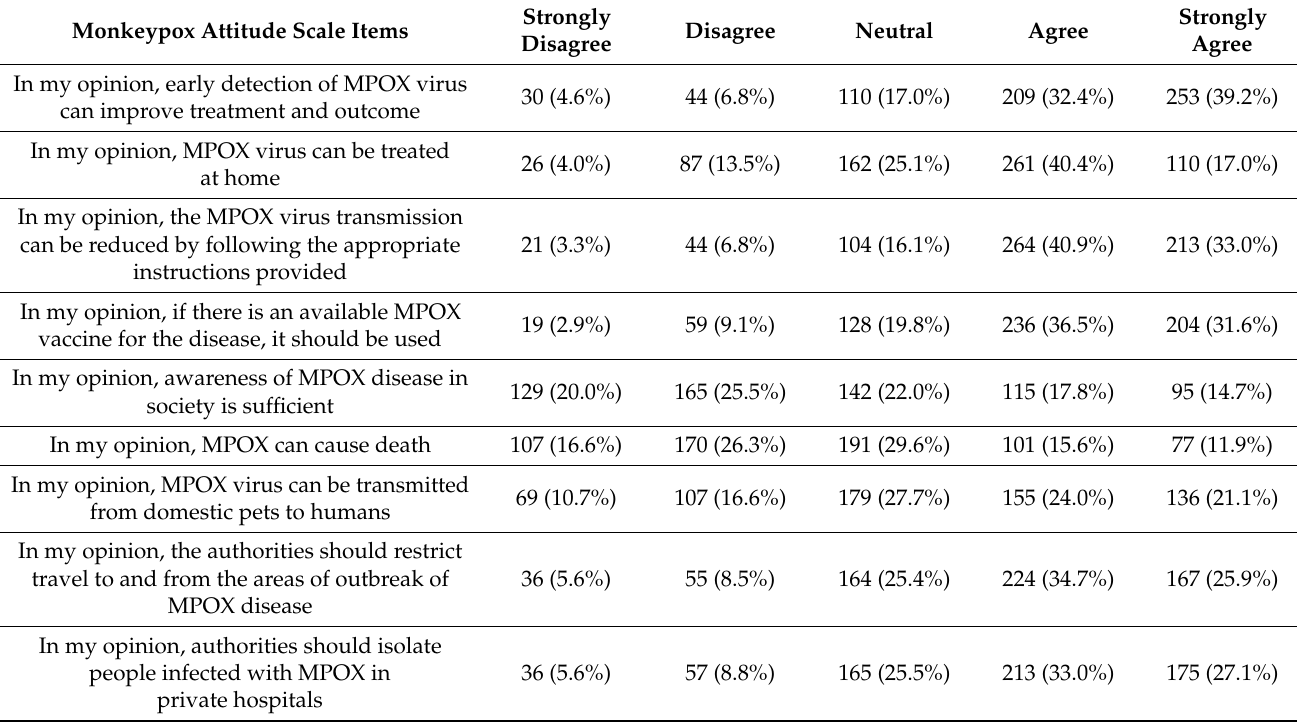
Table 4. Description of the monkeypox attitude scale items’